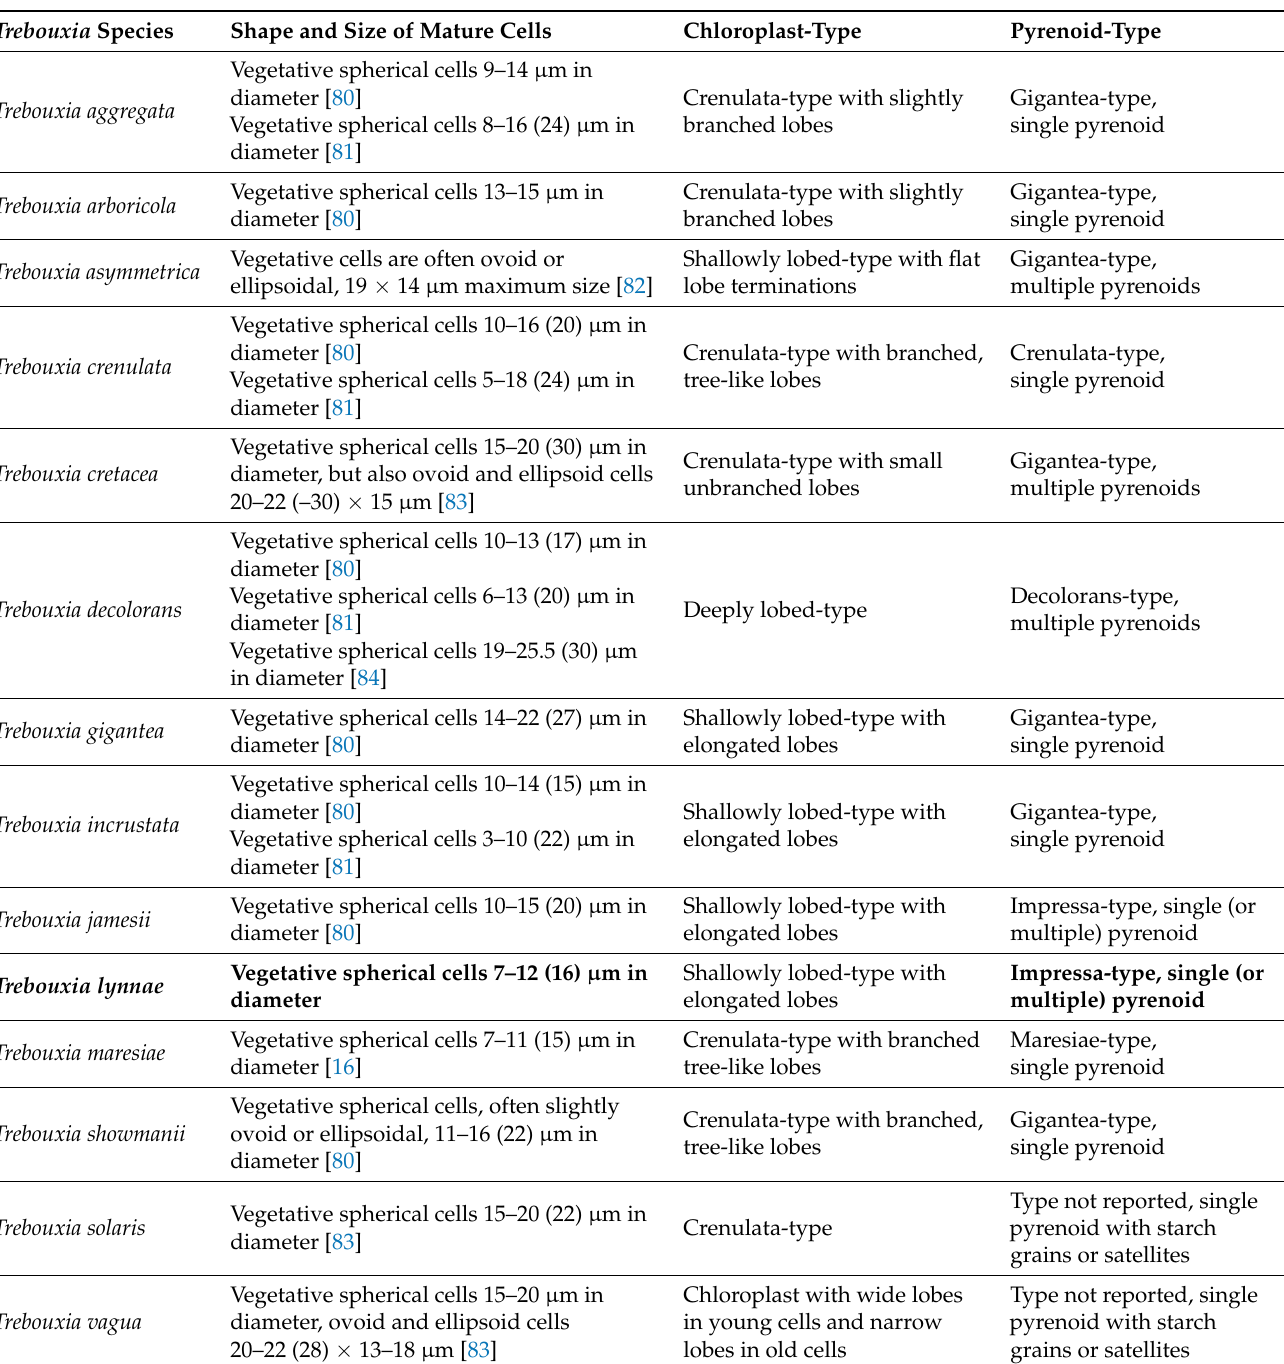
Table 1. A comparative table of the morphological and ultrastructural traits of Trebouxia species on clade